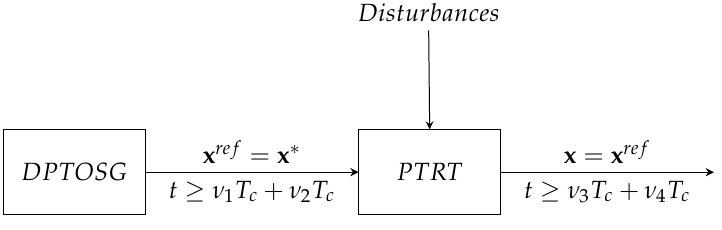
Figure 1. Graphical representation of the proposed